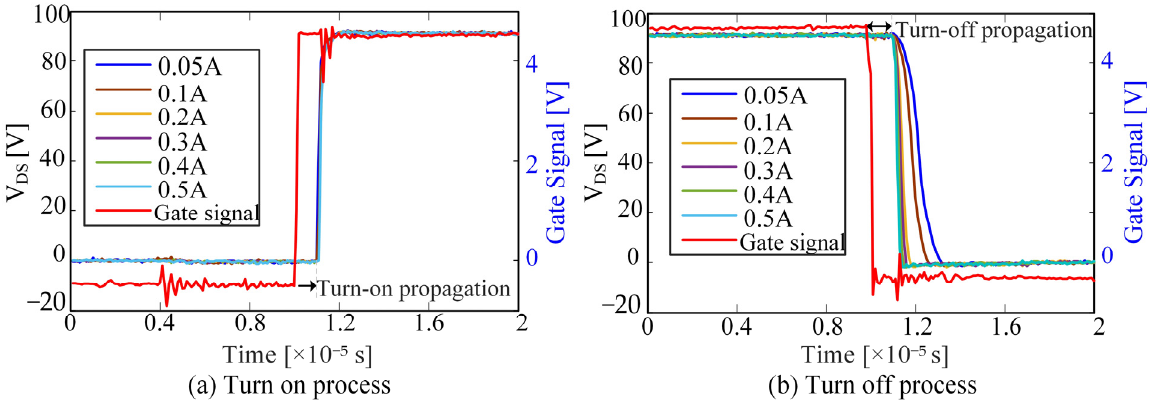
Figure 8. Influence of positive current with different amplitudes on the drain source voltage.